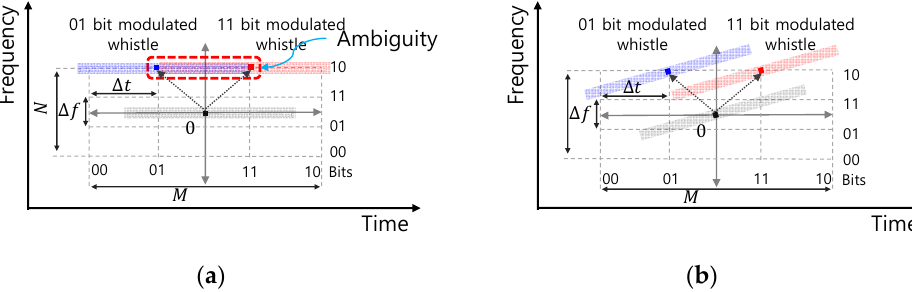
Figure 2. Examples of Time Frequency Shift Keying (TFSK) modulated signals: ( a ) zero-chirp rate whistle pattern (chirp rate: 0 Hz/s), ( b ) Up-chirp whistle pattern (chirp rate is larger than 0 Hz/s).